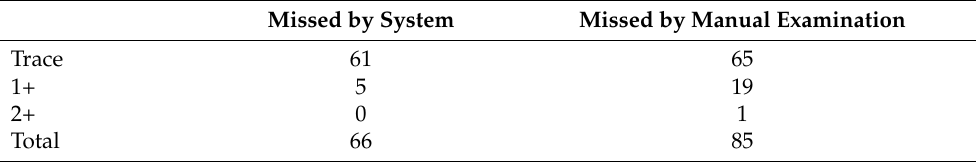
Table 8. The number of missed cases by the automation system and manual microscopy. Missed by System Missed by Manual